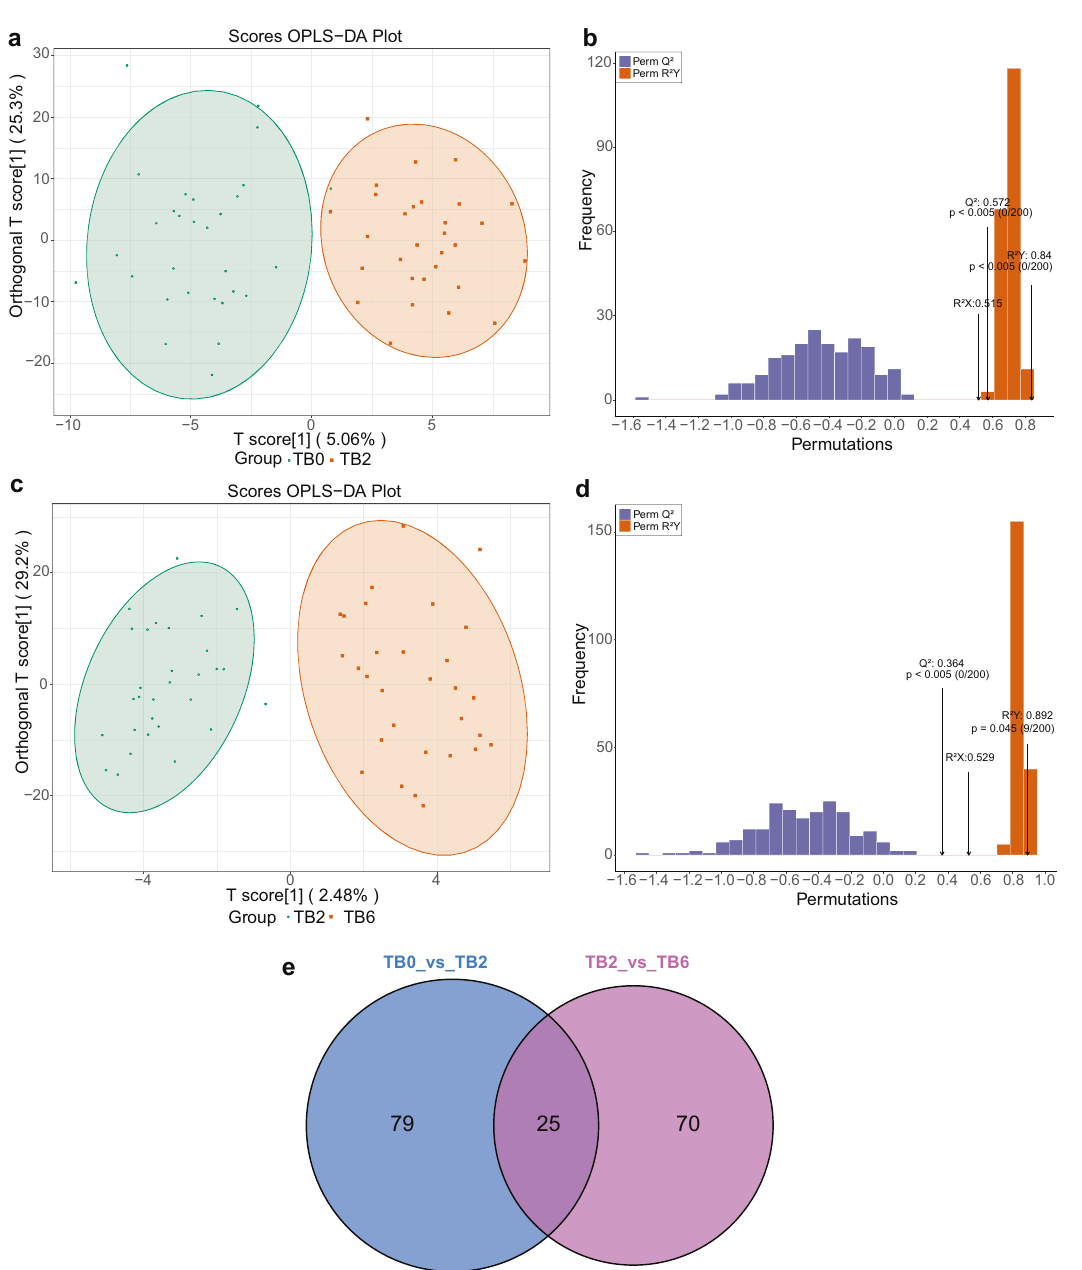
Fig. 2 Establishment and validation of OPLS-DA model (TB0 group vs. TB2 group, TB2 group vs. TB6 group), and screening of dynamically changing lipids. a OPLS-DA model was able to separate the TB2 group from the TB0 group clearly based on the selected lipid metabolites. b The model has good prediction ability, permutation test showed that R2X (cum) = 0.515, R2Y(cum) = 0.840, Q2(cum) = 0.572. c OPLS-DA model was able to separate the TB6 group from the TB2 group clearly based on the selected lipid metabolites. d The model has good prediction ability, permutation test showed that R2X (cum) = 0.529, R2Y(cum) = 0.892, Q2(cum) = 0.364. e In all, 25 lipid metabolites with the signi fi cant statistical difference between the TB0 group and TB2 group, and TB2 group and TB6 group were found in the Venn intersection of the comparison cells. Furthermore, Tsukahara and others 29 and Zhang et al. 30 all biomarkers for evaluating the therapeutic effect in TB patients. LPA is an effective bioactive phospholipid, which can induce cell reported that lysophosphatidic acid (LPA) can activate intracellular proliferation, migration, cytokine release, and other cellular transcription factor peroxisome proliferator-activated receptor γ reactions. It can be produced within and outside of cells through (PPAR- γ ), while PPAR- γ activation during Mtb infection can induce the deacetylation of phosphatidic acid, the phosphorylation of accumulation of lipid droplets in foamy macrophages, 31,32 monoacylglycerol, and the hydrolysis of lysophosphatidylcho- antagonize or stimulate upstream regulator (such as vitamin D line. 27 Delogu et al. 28 found that LPA may play an important receptor) to inhibit the activation of PPAR- γ . 33 Elimination of the protective role in the primary infection of Mtb by enhancing the accumulation of lipids in macrophages infected with Mtb can innate immune response of macrophages and alveolar epithelial inhibit the growth of Mtb in the host. Therefore, we speculated Signal Transduction and Targeted Therapy (2021)